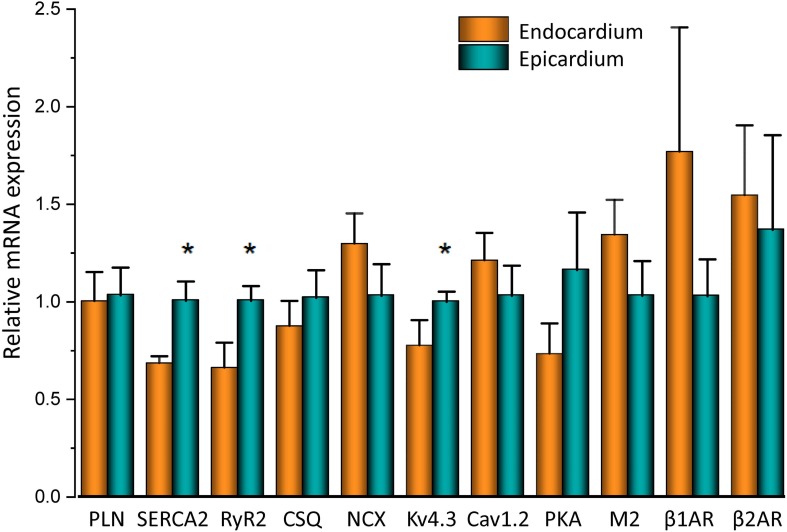
mRNA differences across the ventricular wall. Endocardial and epicardial mRNA quantification of the different proteins involved in Ca2+ signaling. mRNA levels (bars) were normalized to the housekeeping gene, GAPDH and expressed as mean ± SEM. N = 5. *p < 0.05.